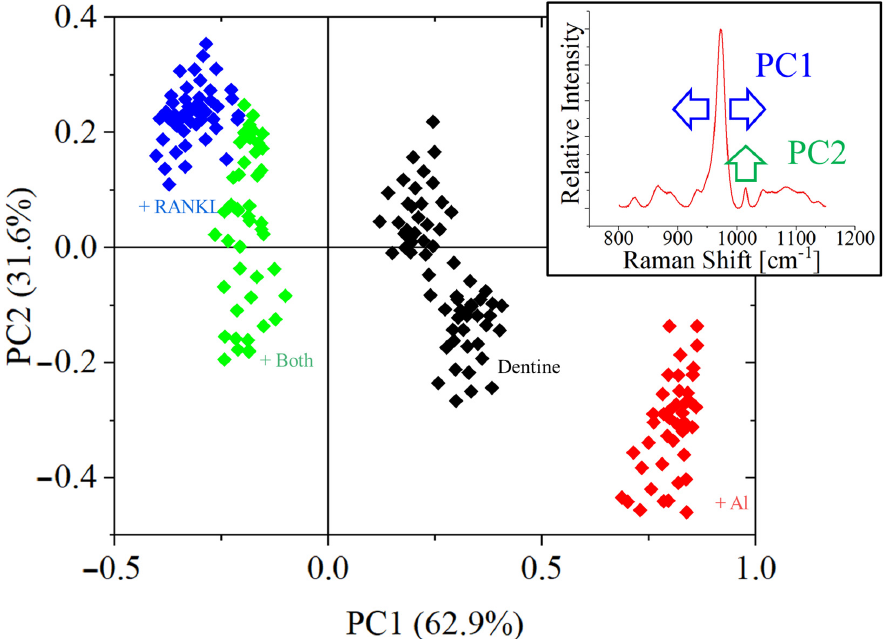
Figure 10. PCA analysis for the hydroxyapatite region of the dentine samples, PC1 related to the bandwidth of the 960 cm − 1 octacalcium phosphate vibration and PC2 related to the intensity of the phenylalanine band at about 1004 cm − 1 .